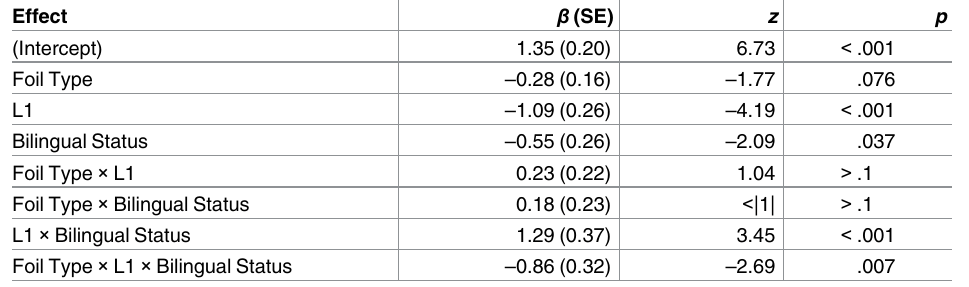
Table 4. Logit mixed-effects model with best fit on listeners’ accuracyin condition with F0 cues (with monolingual French listeners’ performance on non-word foils as baseline) a .